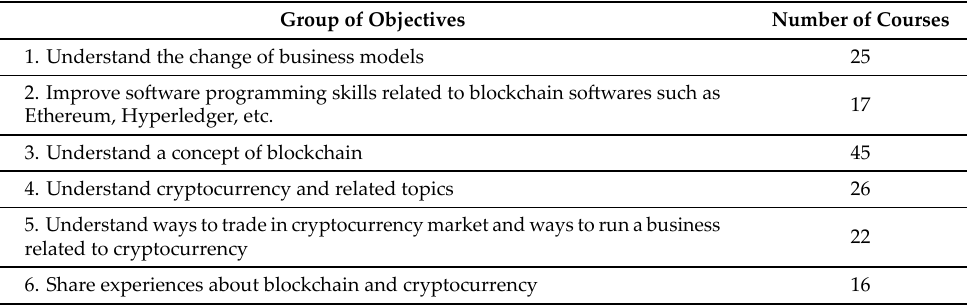
Table 3. A table showing the frequency of objectives in which each course